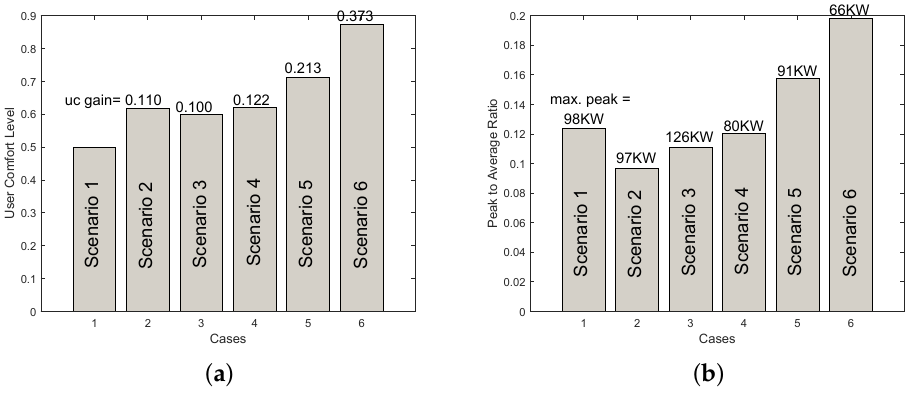
Figure 12. Performance metric and PAR. ( a ) UCL achieved; ( b )